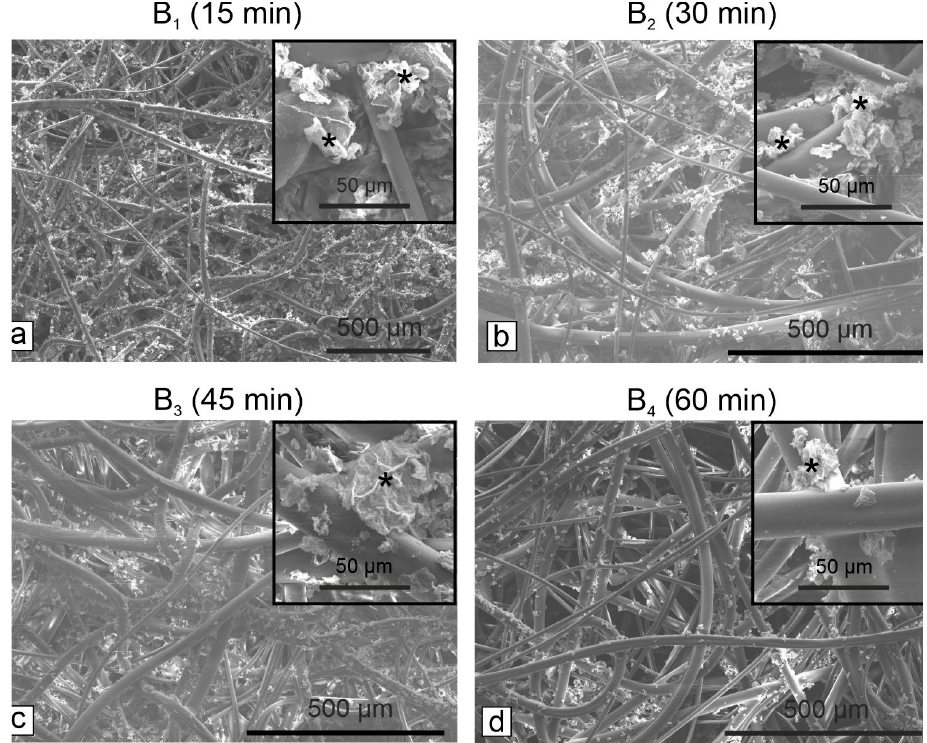
Figure 5. SEM micrographs of the HEPA filters treated with 2 mg/mL Gr-Ag (5 wt% Ag) hybrid (marked with *) for different time periods: ( a )—15 min (B 1 ), ( b )—30 min (B 2 ), ( c )—45 min (B 3 ), ( d )—60 min (B 4 ). The CFU measurements showed that all tested materials had bactericidal effects against both Gram-negative and Gram-positive bacteria models (Table 2). Table 2. The colony forming units (CFU/mL) method indicating the bactericidal/bacteriostatic ef- fect of the HEPA filters treated with 2 mg/mL of Gr-Ag (5 wt% Ag) hybrid for different time peri- ods .